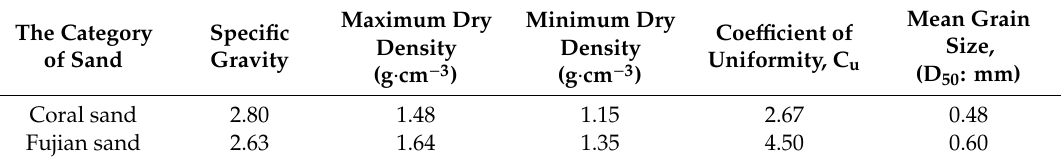
Figure 2. Grain-size distribution curves of coral sand and Fujian sand. Table 2. Physical properties of sand.